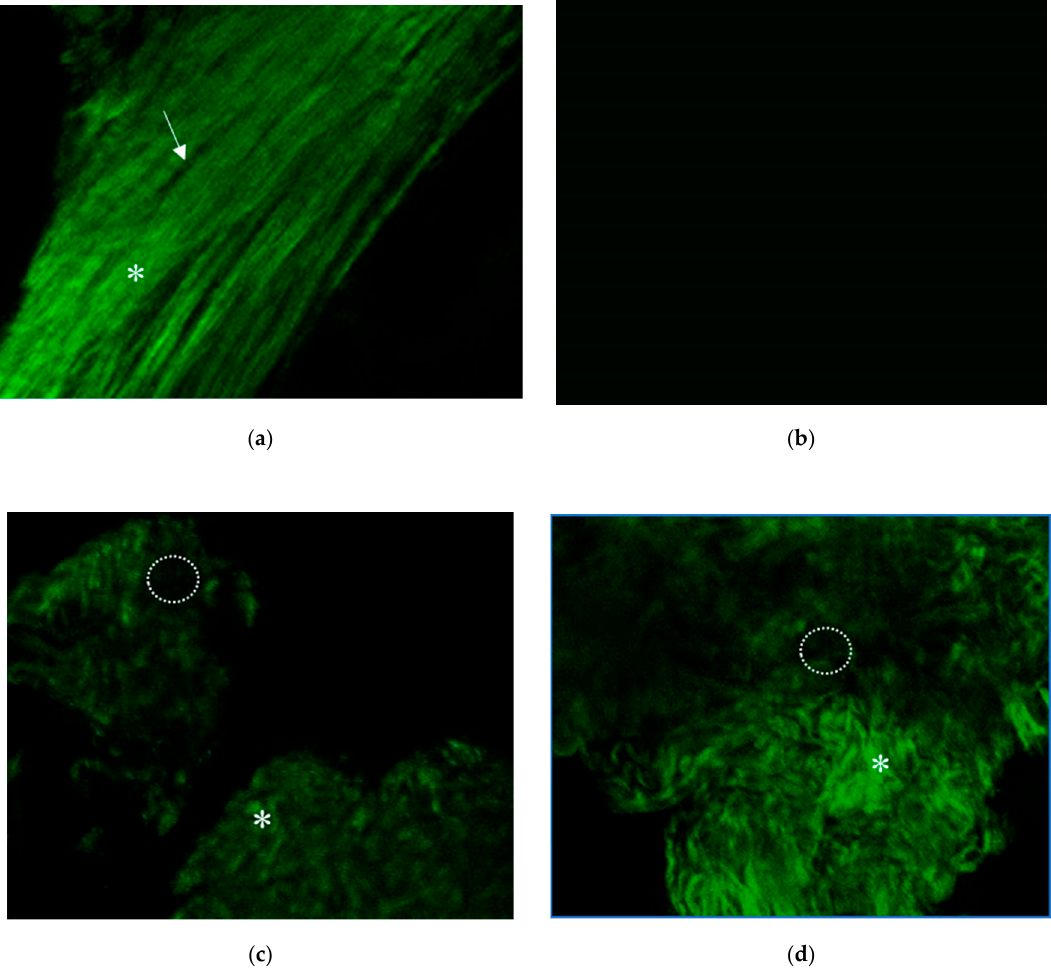
Figure 9. Two-photon excitation microscopy. ( a ) Second harmonic generation (SHG) signals of normal rat femur bone tissue. Green woven fibers (white asterisk) indicate well-aligned type I collagen fibers of mature bone matrix. Dark spindle-shaped areas (white arrow) in this image might present the location of osteocytes. ( b ) SHG signals of Gel-HA / CS / HAP composite before implantation. ( c ) SHG signals of the drill hole site filled with the composite without SDF-1. Some woven type I collagen fibers (asterisk) can be found, which indicate the evidence of new bone formation around the bone defect site. The dark areas (dotted circle) in this picture might be those osteocytes that just migrated in or the residual CS / HAP particles. ( d ) SHG signals of bone defect site implanted with the composite with 100 ng / mL SDF-1. Stronger signals of collagen fibers can be seen.